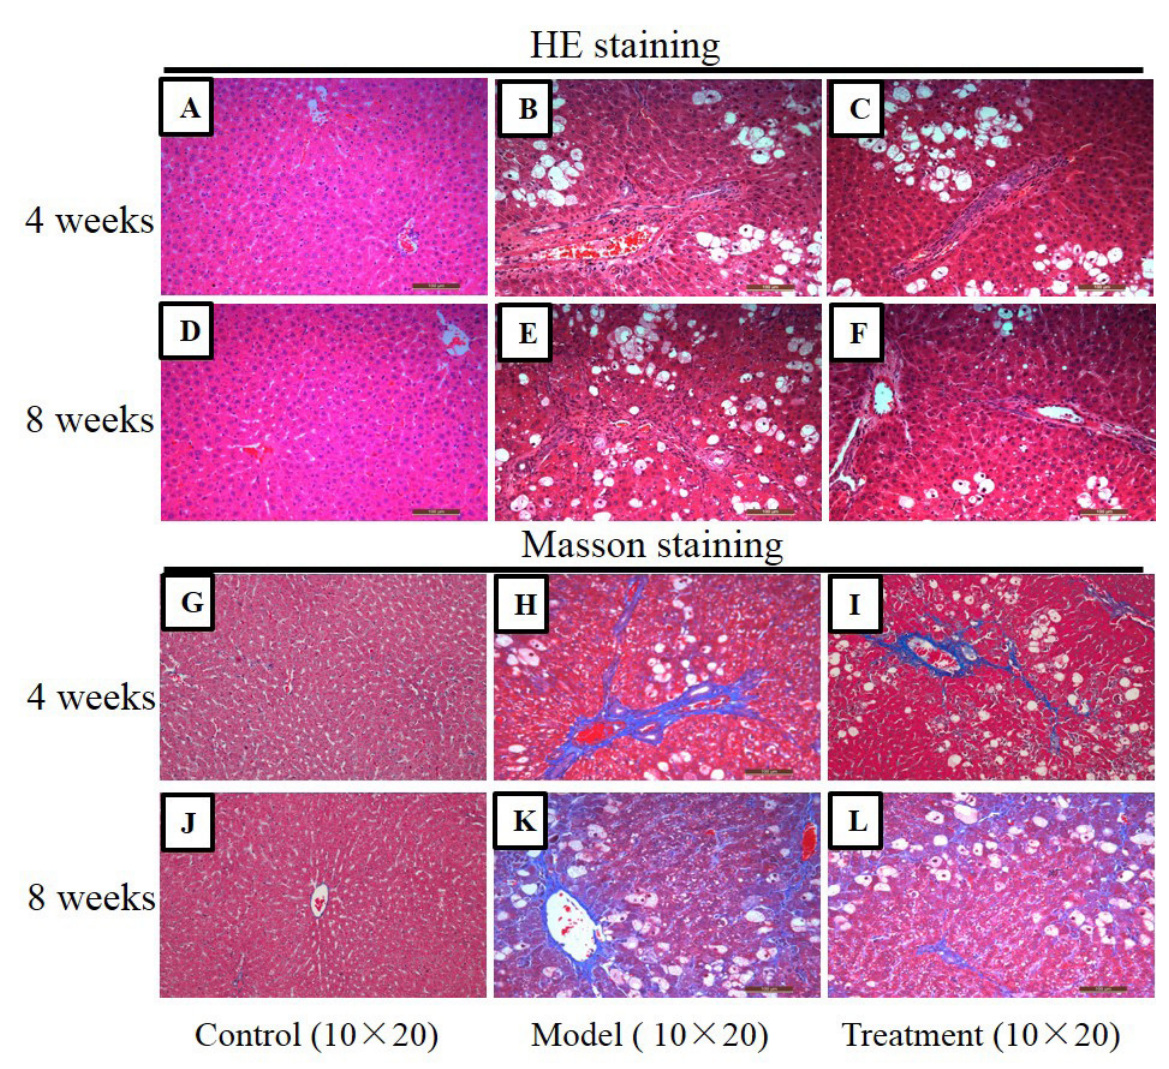
Figure 1: Hematoxylin–eosin staining and Masson staining of rat liver tissues at Weeks 4 and 8. A, D, G, J represent the normal liver tissues; B, E, H, K represent the CCl -induced fibrotic liver tissue; C, F, I, L: DHZCP-treated group. (magnification, 4